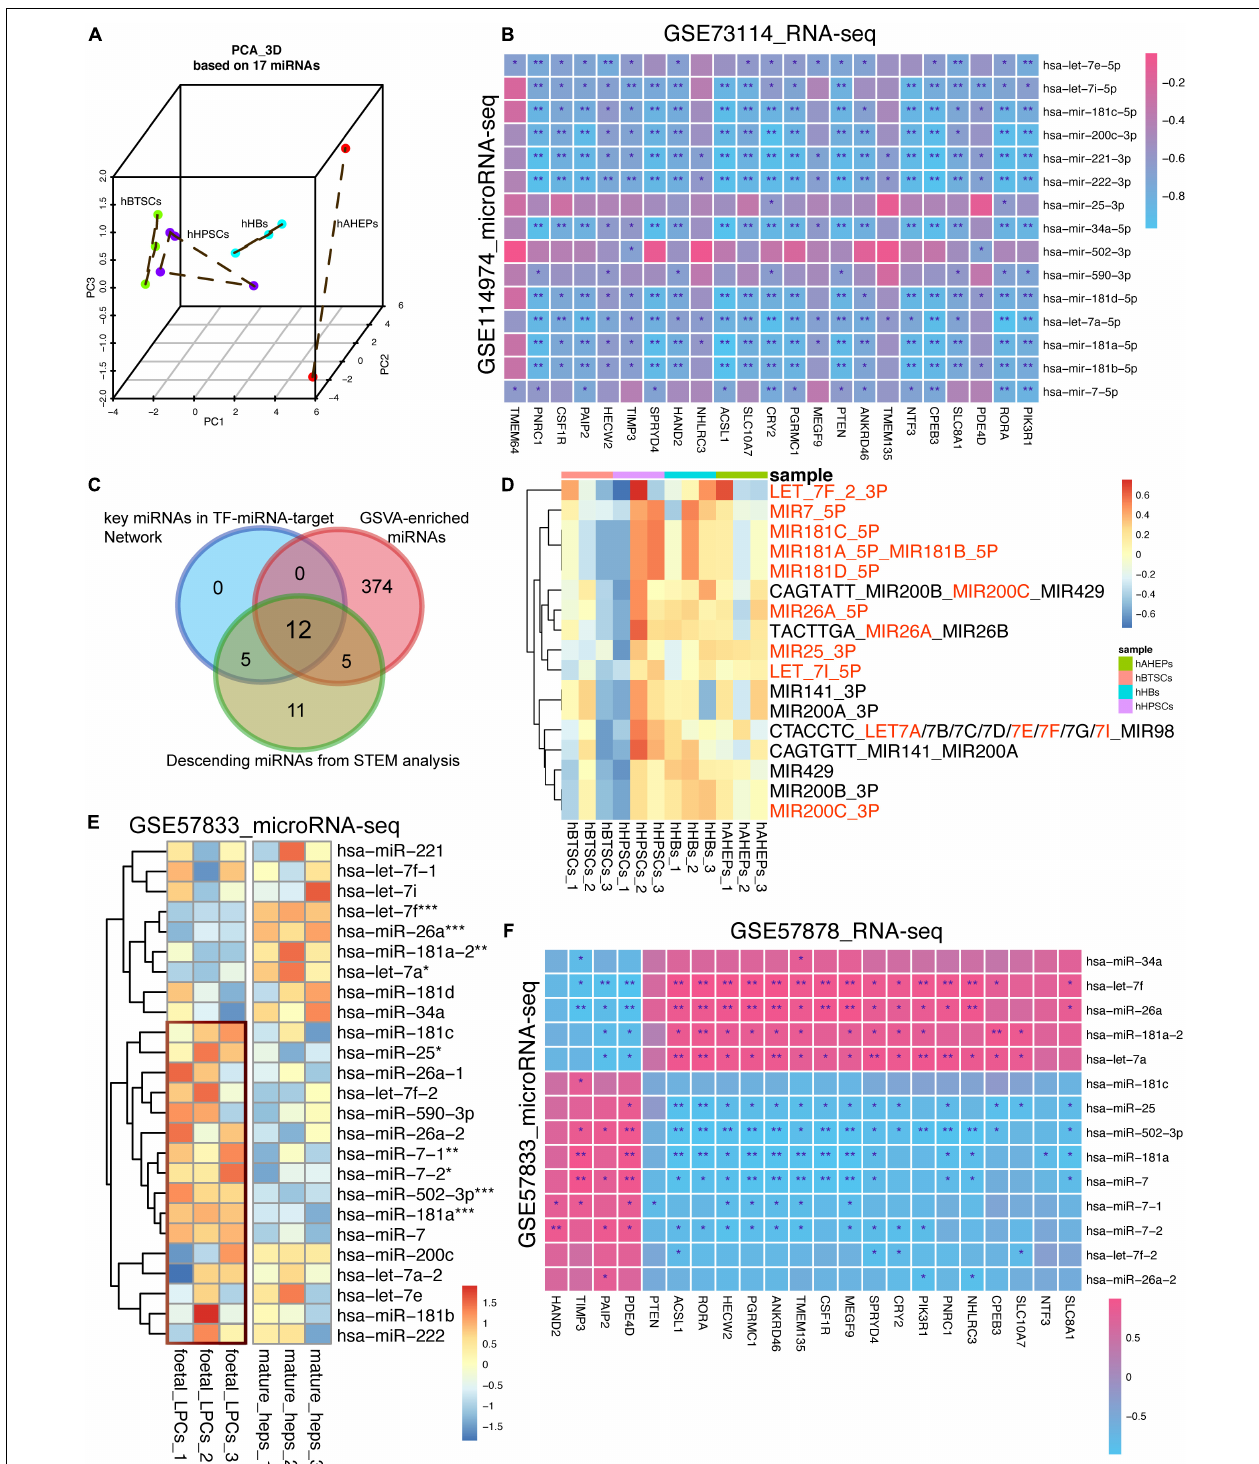
FIGURE 5 | Validating the lineage-specific role of 17 key miRNAs in hepatic maturation. (A) 3D PCA analysis of four stages of hepatic lineage based on 17 miRNAs. (B) Correlation analysis based on the microRNA-seq (GSE114974) and RNA-seq data (GSE73114). * P < 0.05, ** P < 0.01, and *** P < 0.001. (C) Venn plot of miRNAs obtained from different bioinformatic methods. (D) Expression profiling of 17 GSVA-enriched miRNA terms, which were also involved in the downwardly expression miRNAs obtained from STEM analysis. (E) Expression of 17 key miRNAs in GSE57833 dataset. * P < 0.05, ** P < 0.01, and *** P < 0.001. (F) Correlation analysis based on the microRNA-seq (GSE57833) and RNA-seq data (GSE57878). * P < 0.05, ** P < 0.01, and *** P < 0.001.